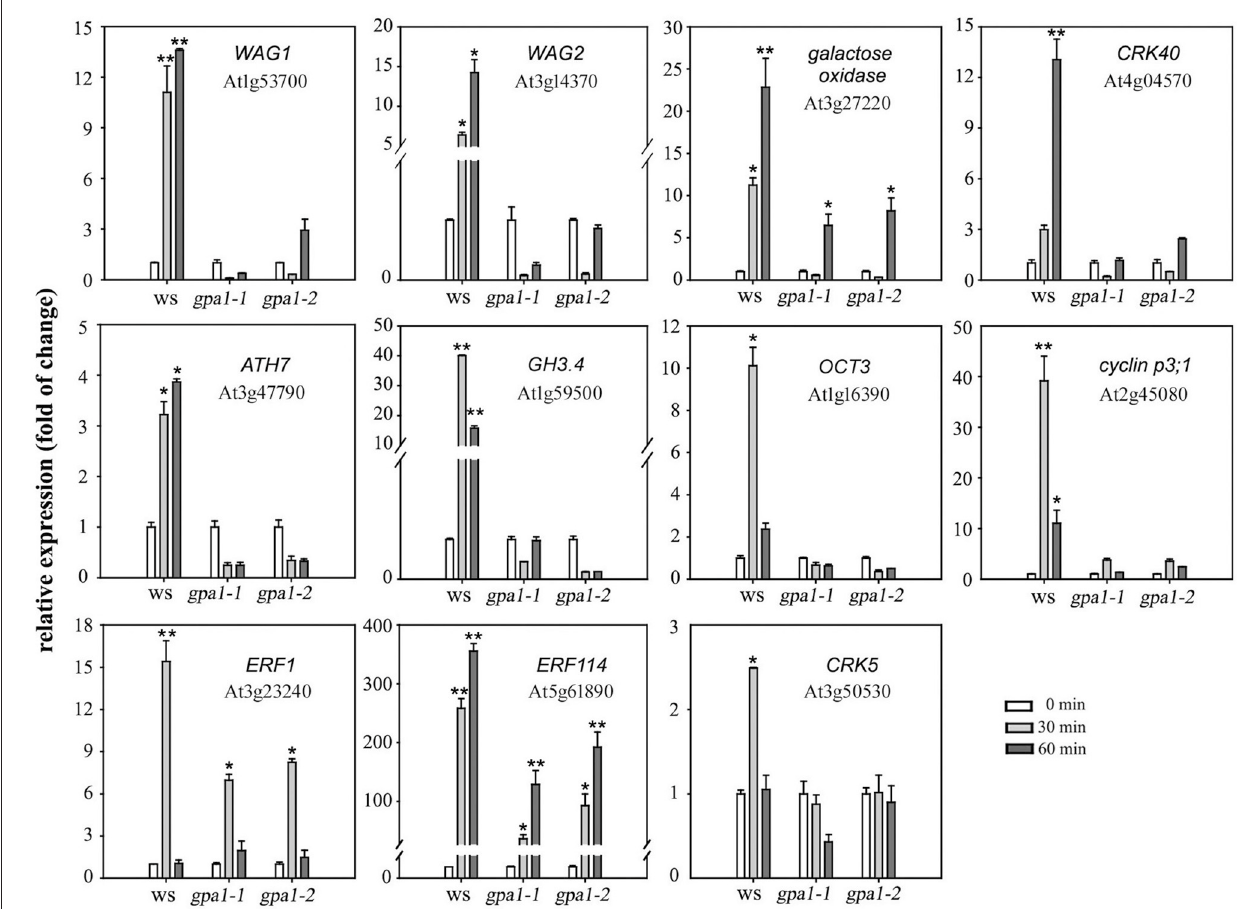
FIGURE 9 | Heterotrimeric G α is involved in eATP-regulated functional gene expression. Seedlings grown in 1/2 MS medium for 4 days were transplanted onto a 0.5mM ATP-containing jointed medium. After 30 and 60 min, roots were cut to extract total RNA, and the expression levels of several functional genes were measured by real-time qPCR. The relative level (fold of change) of gene expression in WS and G α null mutants ( gpa1-1 and gpa1-2 ) is showed. Gene names and the corresponding gene loci are noted in each figure. Data from 3 replicates were calculated to get mean ± SD. Student’s t -test p -values: * p < 0.05, ** p < 0.01.